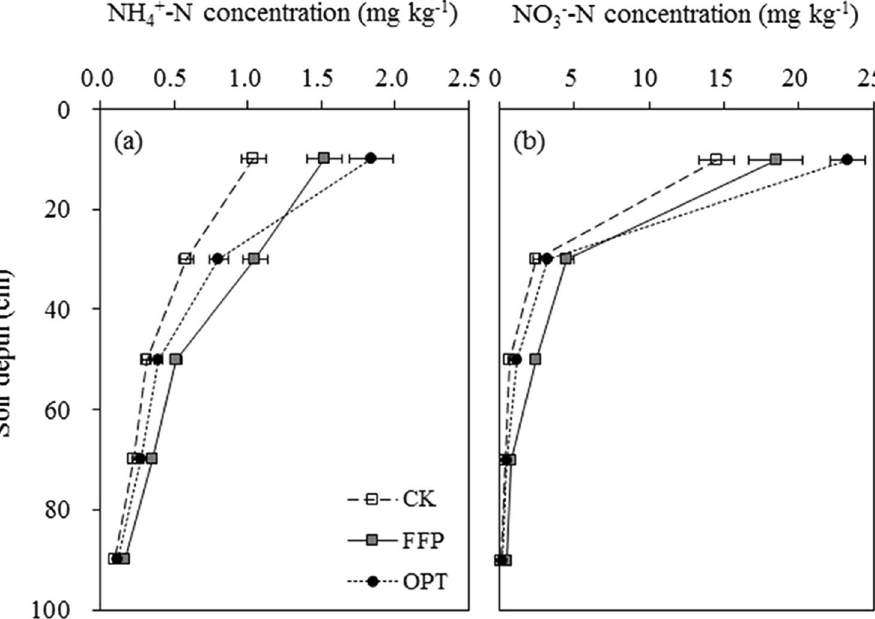
Figure 2. Distribution of NH 4 + -N ( a ) and NO 3 − -N ( b ) concentrations in the profiles of 0–100 cm soil depths at rice harvest in the Rugao site in 2013.